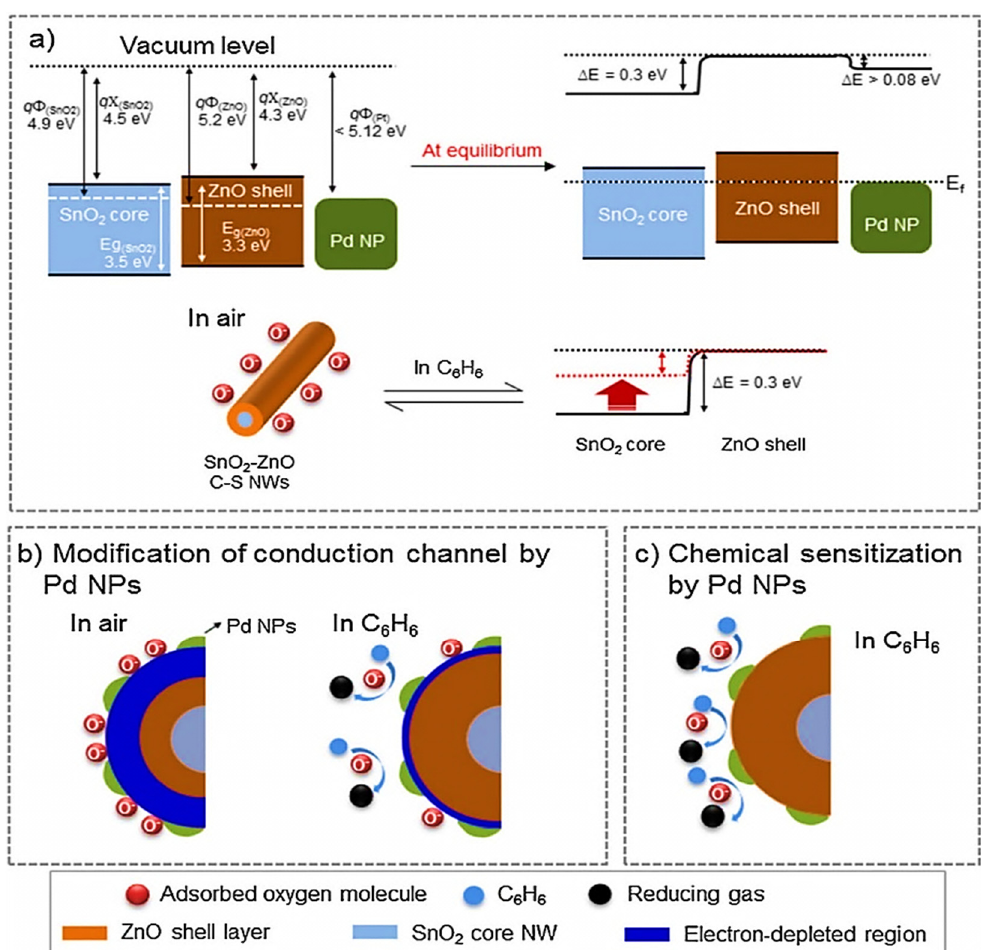
Figure 10. ( a ) Schematics of the energy levels of ZnO, SnO 2 , and Pd, ( b ) conduction channel modification in the shell layer, and ( c ) the CS effect achieved through Pd NPs. Reproduced from [83] with the permission of Elsevier.